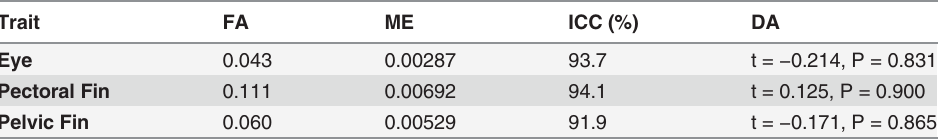
Table 1. Descriptive statistics of FA for each of the three measured traits. Trait FA ME ICC (%) DA Eye 0.043 0.00287 93.7 t = − 0.214, P = 0.831 Pectoral Fin 0.111 0.00692 94.1 t = 0.125, P = 0.900 Pelvic Fin 0.060 0.00529 91.9 t = − 0.171, P = 0.865 FA and ME (measurement error, see text for details) were calculated from linear mixed model analysis. ICC (interclass correlation coef fi cient [FA/(FA+ME)]) is an estimate of the repeatability of FA measures. DA are tests for directional asymmetry (null of mean signed FA = 0).